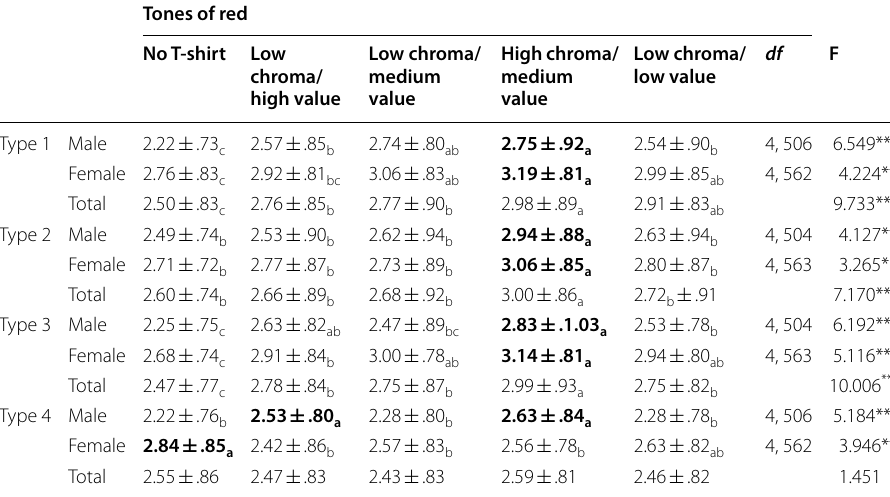
Bold emphasis means the significantly highest average of perceived attractiveness ANOVA: analysis of variance. Perceived attractiveness scale: 1 (strongly disagree) to 5 (strongly agree). Means were ranked by a, b, and c, ordered by the magnitude of the value *p .01, **p .001, ***p ≤ ≤ ≤